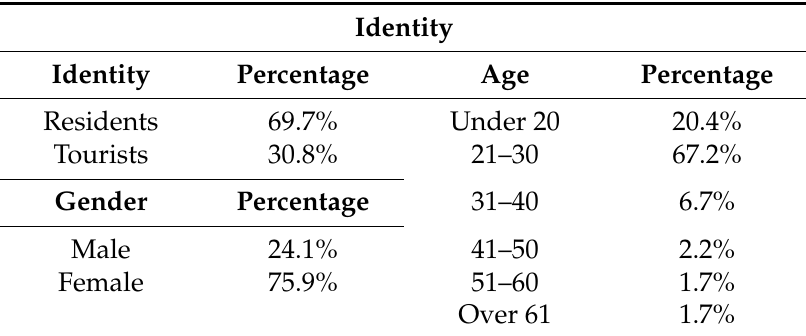
Table 4. Descriptive characteristics of the